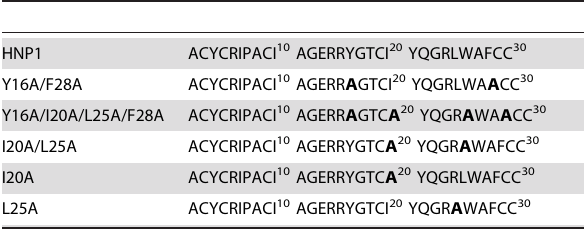
Table 1. The amino acid sequences of wild type HNP1 and HNP1